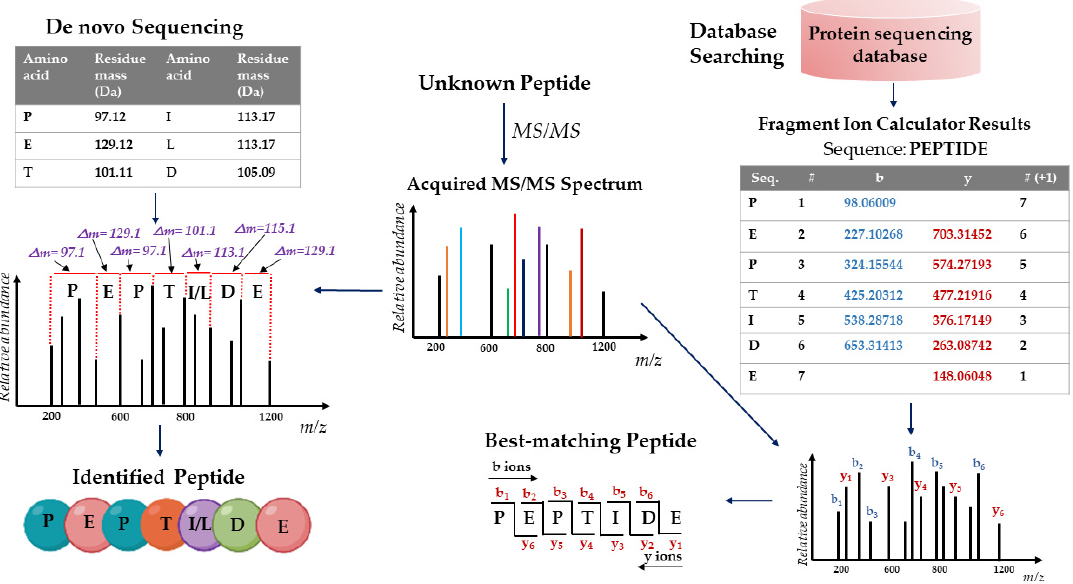
Figure 2. Identified peptides by de novo sequencing and database sequencing from tandem mass spectra.